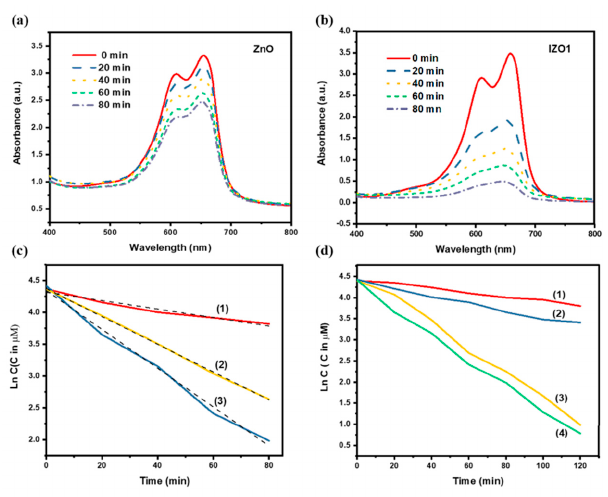
Figure 19. Absorption properties and photodegradation tests. Absorbance spectra of methylene blue at regular intervals of time using photocatalysts ( a ) ZnO and ( b ) IZO1. ( c ) Degradation rate constants obtained by plotting Ln C vs. time for (1) ZnO (2) IZO2 and (3) IZO1. ( d ) Effect of addition of different scavengers (1) addition of 1 mM EDTA (2) addition of 1 mM p-BQ (3) addition of 1 mM t -BuOH and (4) no scavenger addition towards photodegradation of methylene blue using IZO1 photocatalyst. Reproduced with permission from Ref. [93]; published by Elsevier, 2019.